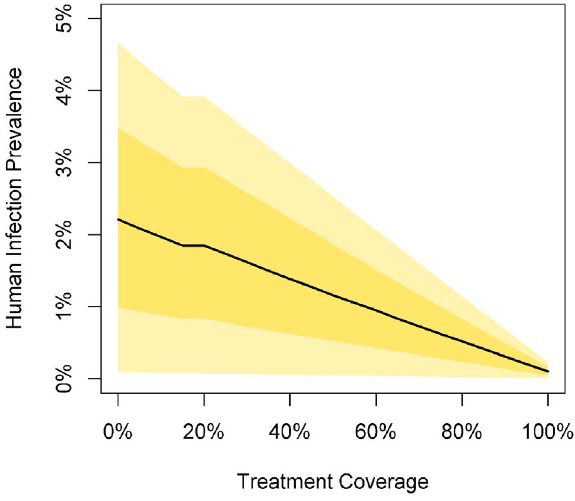
Figure 4. Change in total human infection prevalence with increasing rapid treatment coverage. Shaded areas represent the 95% range (light yellow) and interquartile range (dark yellow); the block line represents the median